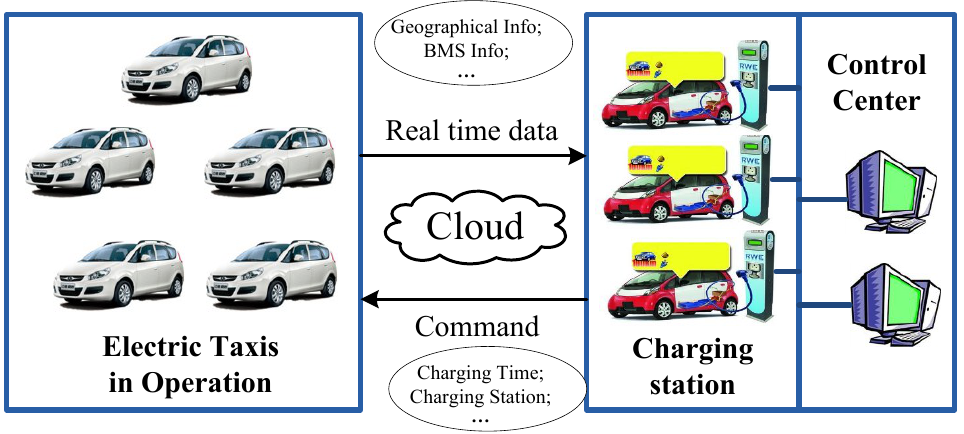
Figure 1. Framework of charging station and electric